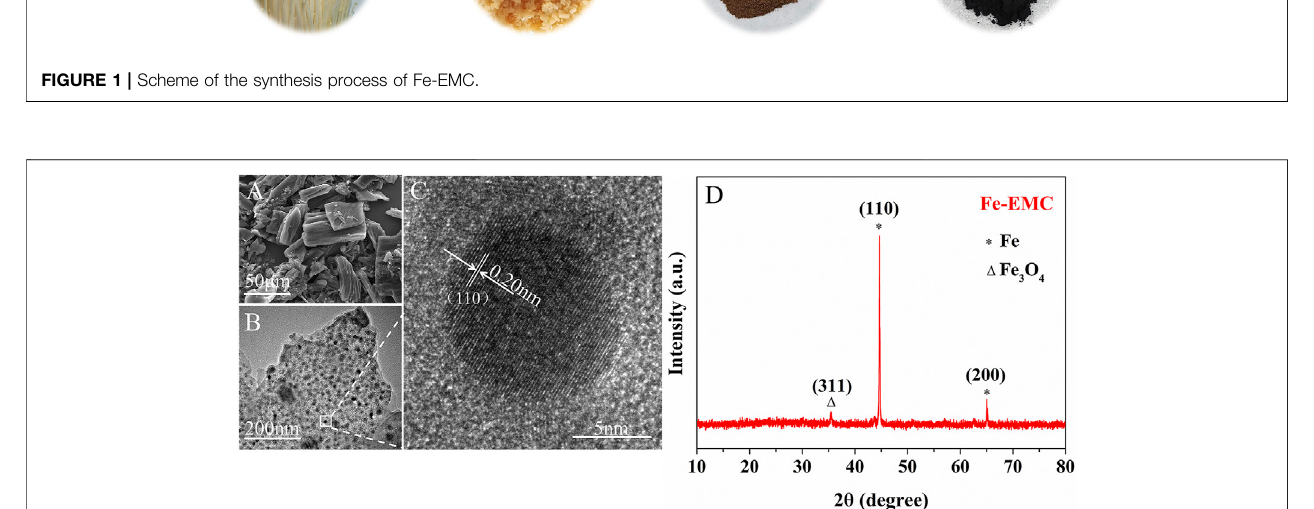
FIGURE 2 | Morphology and structure characterizations of Fe-EMC. (A) SEM; (B,C) HRTEM; (D) XRD.